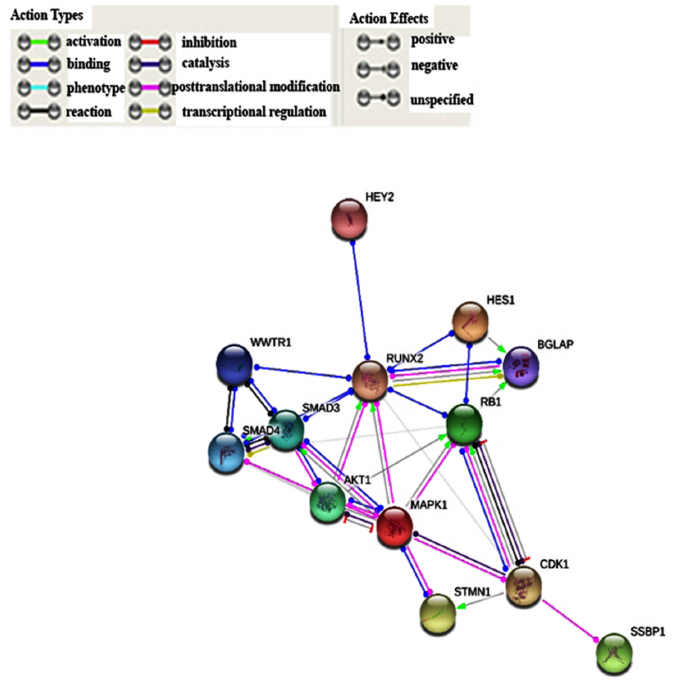
Figure 3. Functional proteins interaction classified according to activity and effect. PPI enrichment p -value: 1.03 × 10 − 7